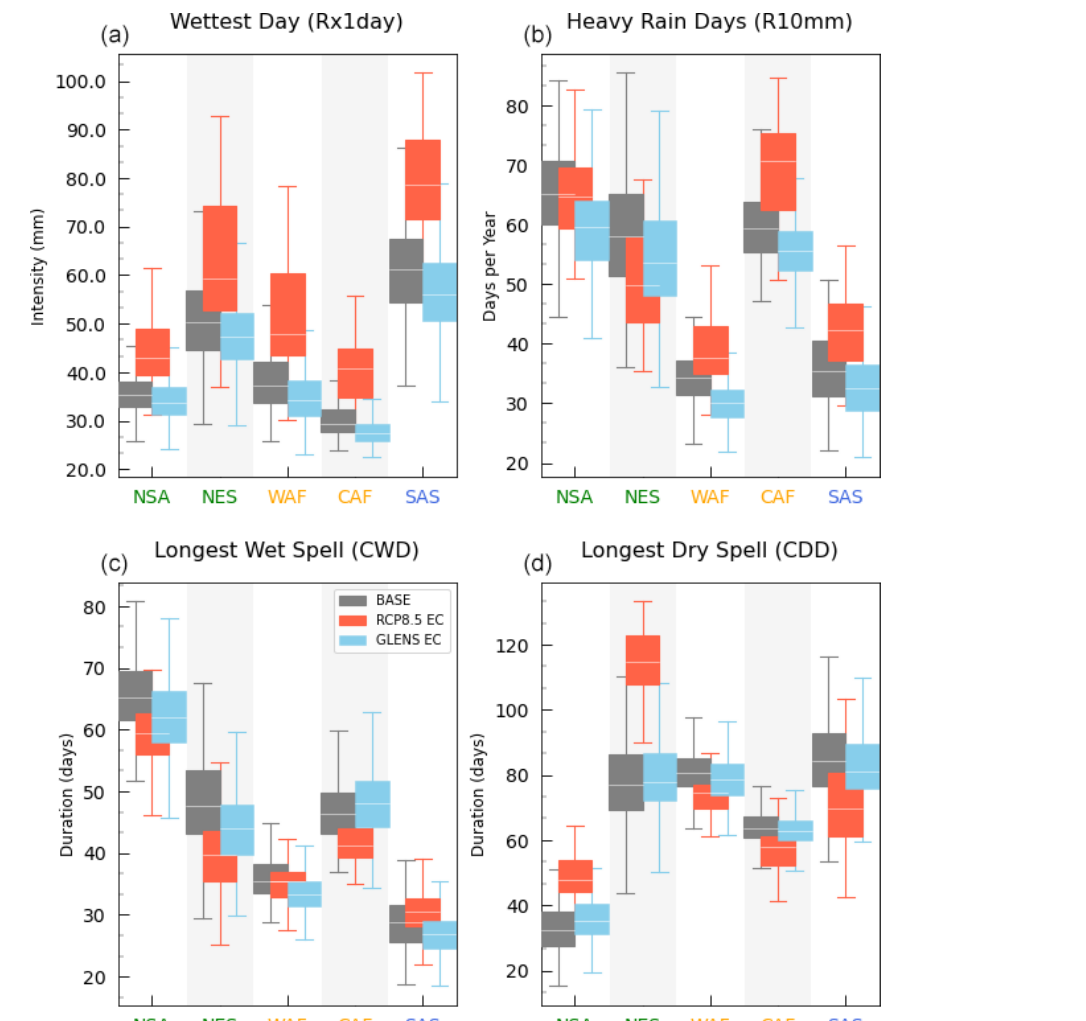
Figure 13. Regional box plots indicating the ensemble ranges of temperature indices for BASE (2010–2030; gray boxes), RCP8.5 EC (2075–2095; red boxes), and GLENS EC (2075–2095; blue boxes) for the annual maximum daily precipitation (wettest day, Rx1day, a ), number of heavy rain days per year (R10mm, b ), longest consecutive spell of wet days per year (longest wet spell, CWD, c ), and longest consecutive spell of dry days per year (longest dry spell, CDD, d ) for the same regions as Fig.